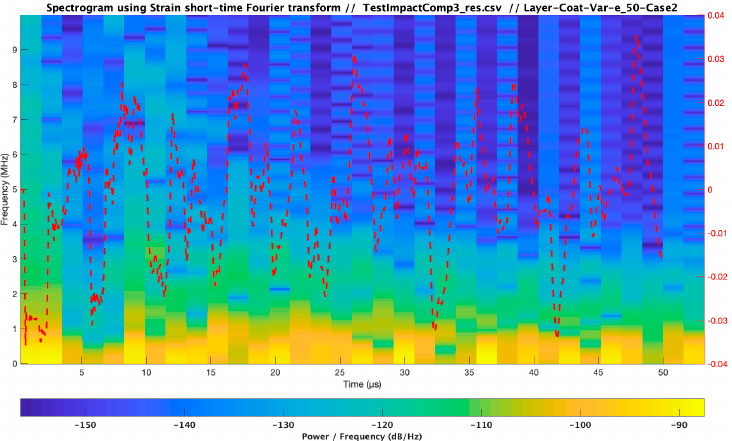
Figure 22. Spectrogram for strain evolution at the middle coating layer. Comparison for coating thickness variation respect to the reference LEP multilayer configuration (Case 2).